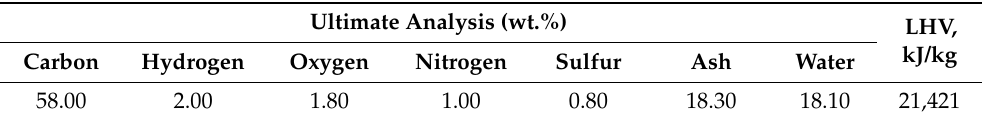
Table 1. Coal composition.